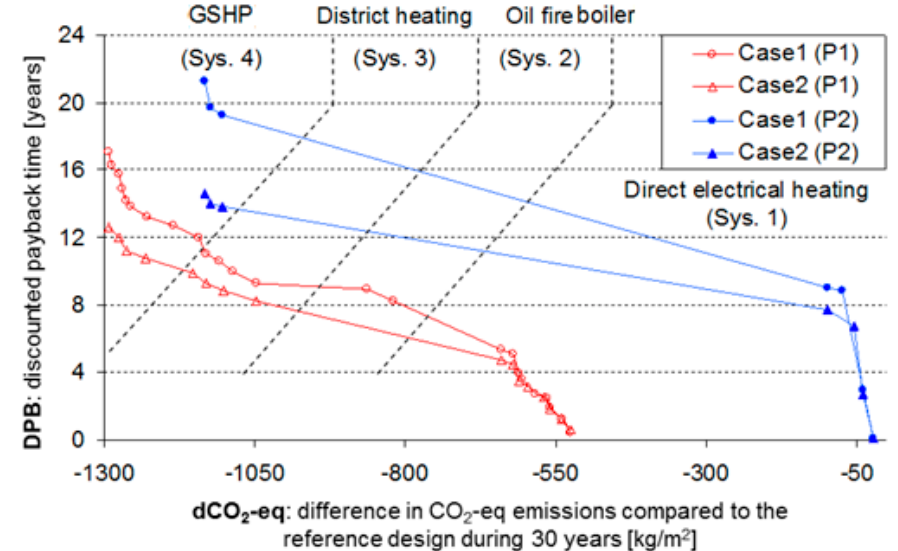
Figure 8. The optimal (Pareto) solutions of the two studied cases. P 1 does not consider the increase in the summertime overheating due to the energy saving measures, P 2 considers the summertime overheating of the reference design (DH 24 = 2400 °C.h) as a constraint for the feasible solutions. The summer overheating is assessed by the degree hours (DH 24 ) as defined in Section 2.1.3.